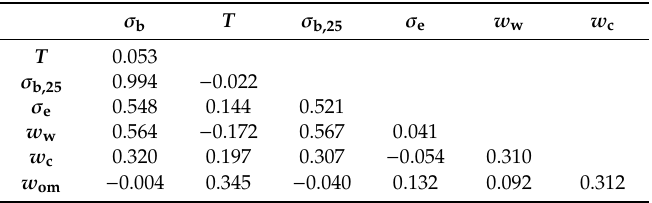
Table 7. Pearson’s product-moment correlation coe ffi cients among the SCT-10 probe measurements and calculations and soil properties in the sites and depths the former were available.